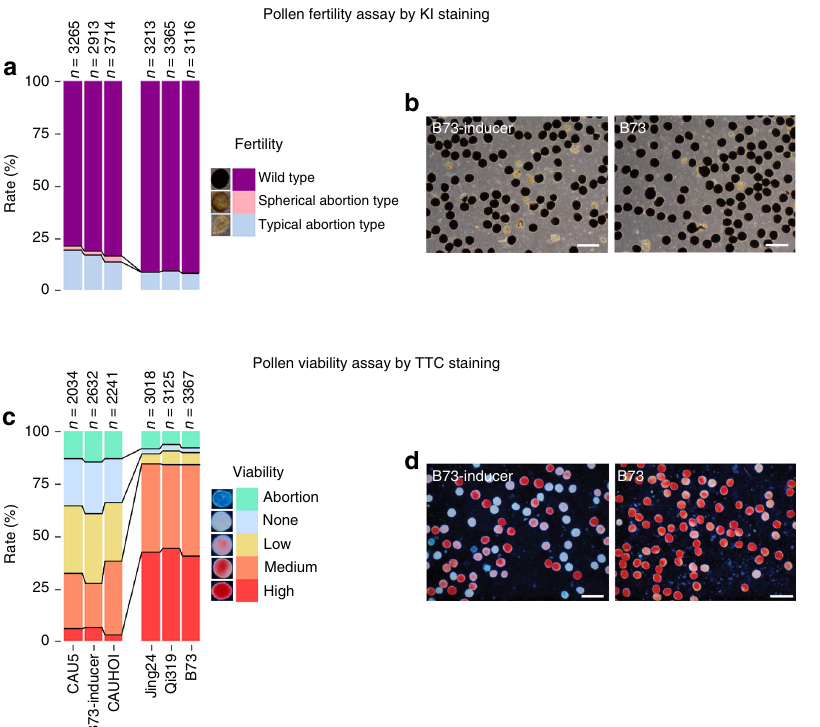
Fig. 1 Pollen fertility and viability differs between regular and inducer lines. a Three levels of pollen fertility, (i) typical abortion type, (ii) spherical abortion type, and (iii) wild type, measured by KI/I 2 staining, and counted in the six lines. b Pollen fertility of B73-inducer and B73, stained by KI/I 2 . c Five degrees of pollen viability, (i) high, (ii) medium, (iii) low, (iv) no viability, and (v) abortion, measured by the TTC staining and counted in the six lines. d pollen viability of B73-inducer and B73, stained by TTC. Scale bar = 1 mm. The fertility and viability photographs and statistic analysis of all six lines are also provided